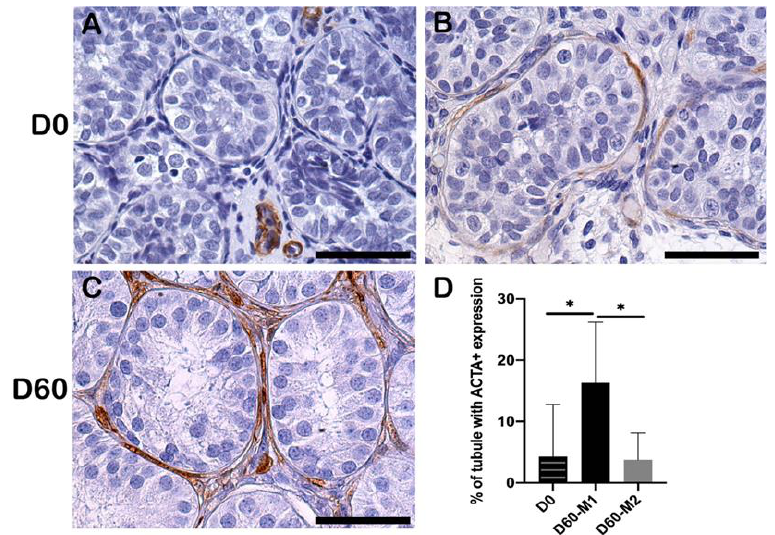
Figure 5. Alpha-smooth muscle actin (ACTA) expression at PTMCs. ( A ) ACTA showed negative expression in PTMCs at D0 and ACTA+ expression on blood vessels. Positive expression of ACTA in PTMCs at D0 ( B ) and D60 ( C ). Scale bar = 5 0 μm. ( D ) Percentage of tubules with ACTA positive PTMCs at D0 and D60. Asterisks indicated statistically significant differences. PTMCs at D0 and D60. Asterisks indicated statistically significant